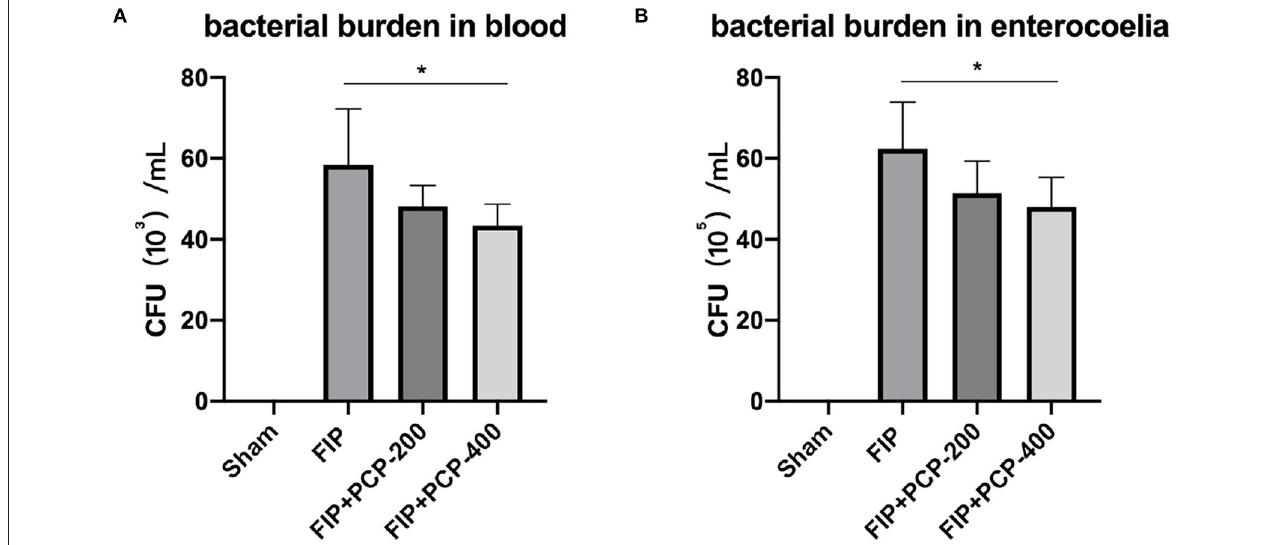
FIGURE 2 | PCP-400 mg/kg/day pretreatment reduced the bacterial burden in peripheral blood (A) and at the enterocoelia (B) . No significant difference between PCP-400 mg/kg/day and PCP-200 mg/kg/day. All presented data are a composite of three independent experiments. * P < 0.05, n = 5 in each group.